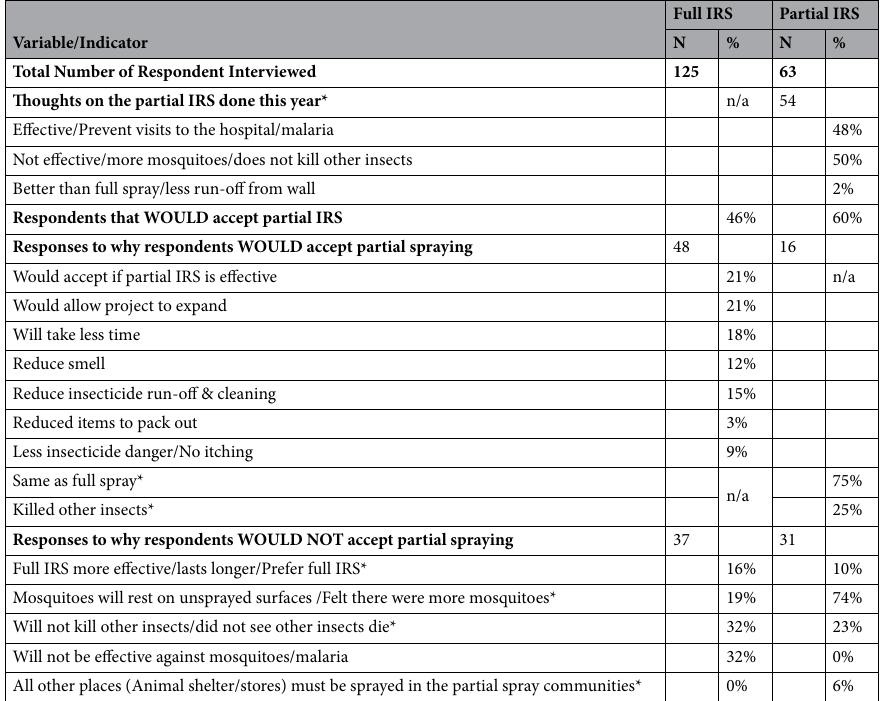
Table 3. Perceptions of community members on partial IRS, as determined through interviews conducted seven months post-spray. *Questions and responses for partial IRS communities only.